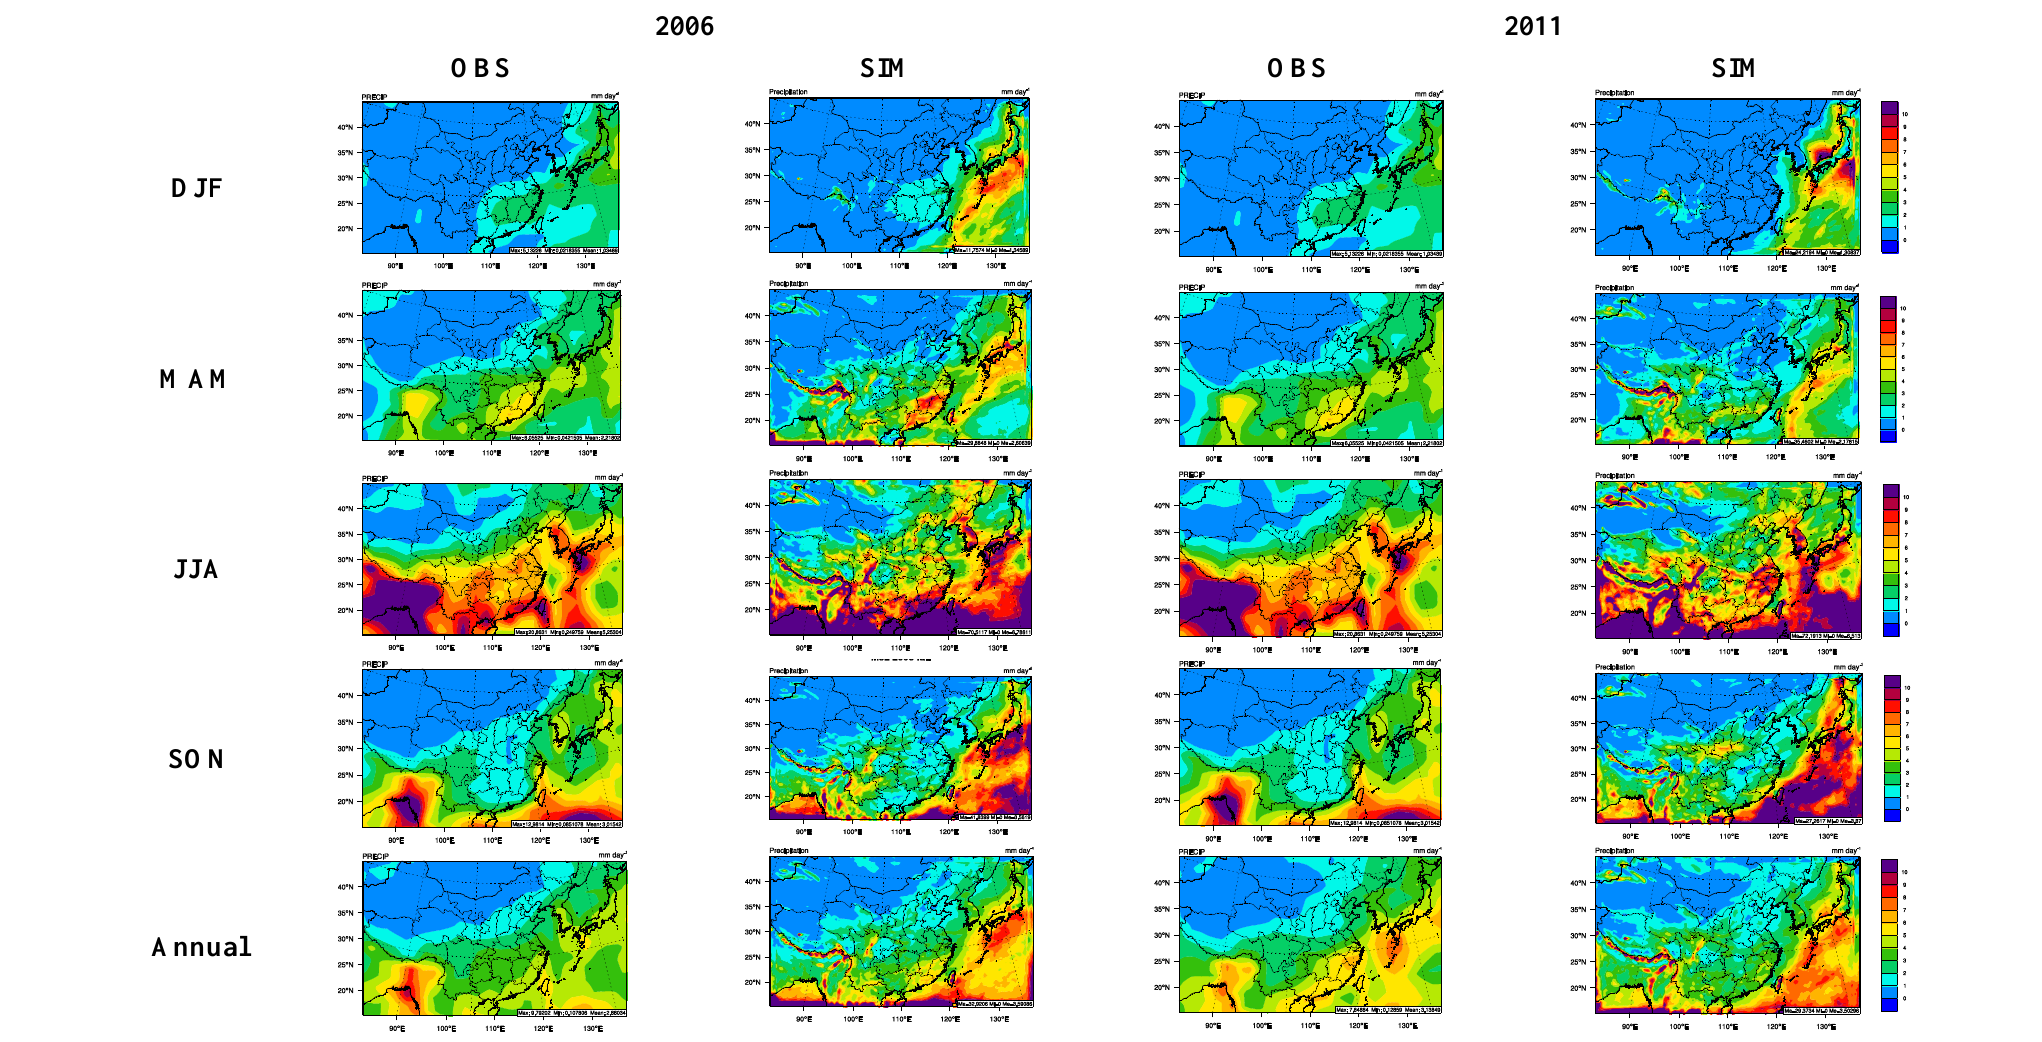
Figure 2. Spatial distributions of simulated seasonal-average precipitation for the 2006 and 2011 simulations with M92 against the GPCP